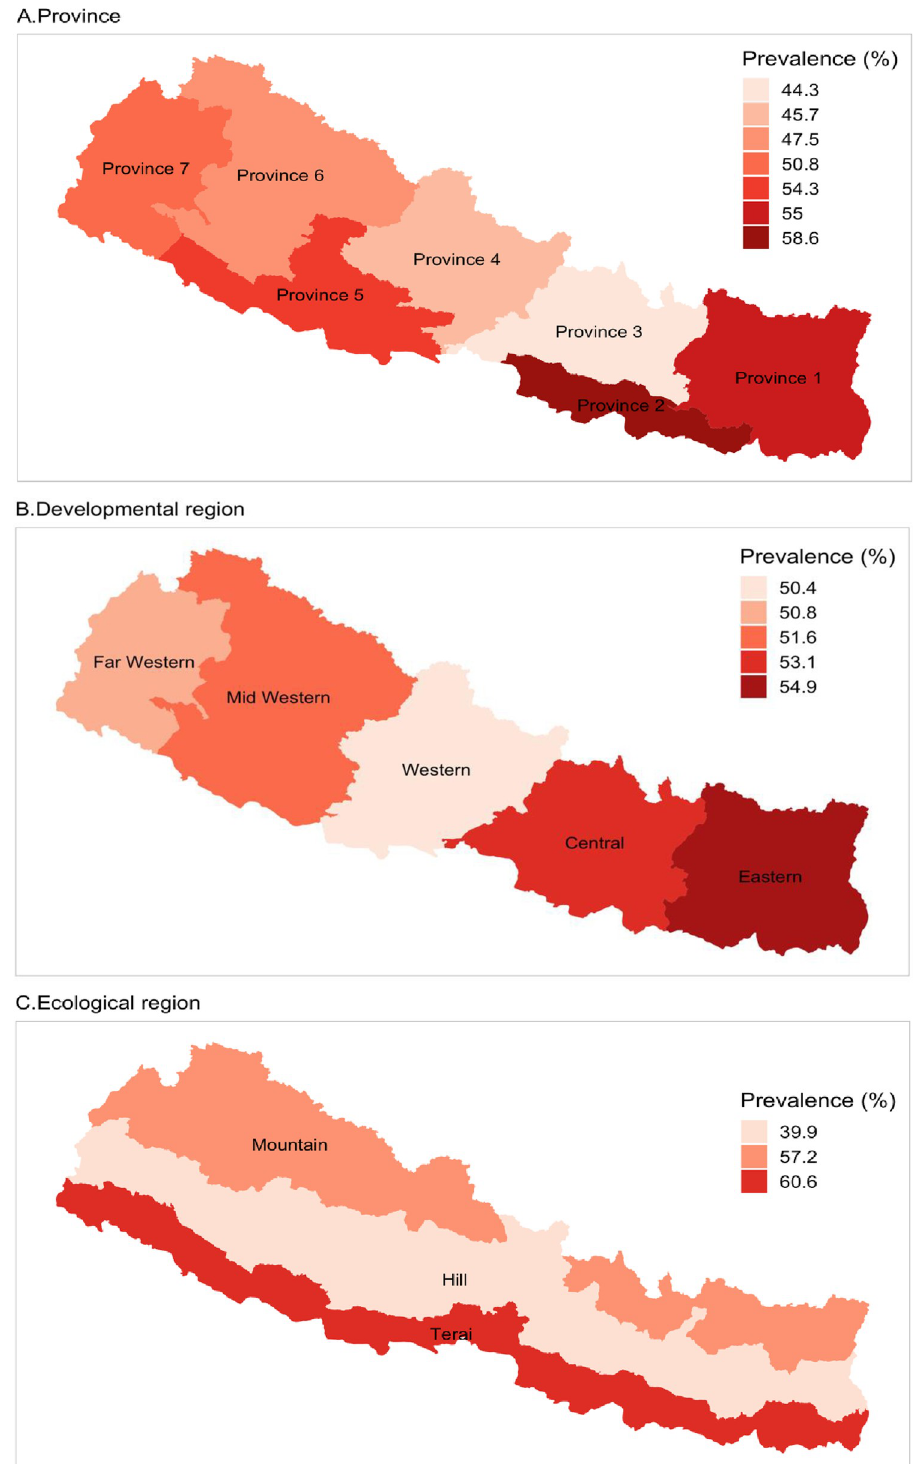
Fig 4. Regional variations in prevalence of any level of anemia among Nepalese children.